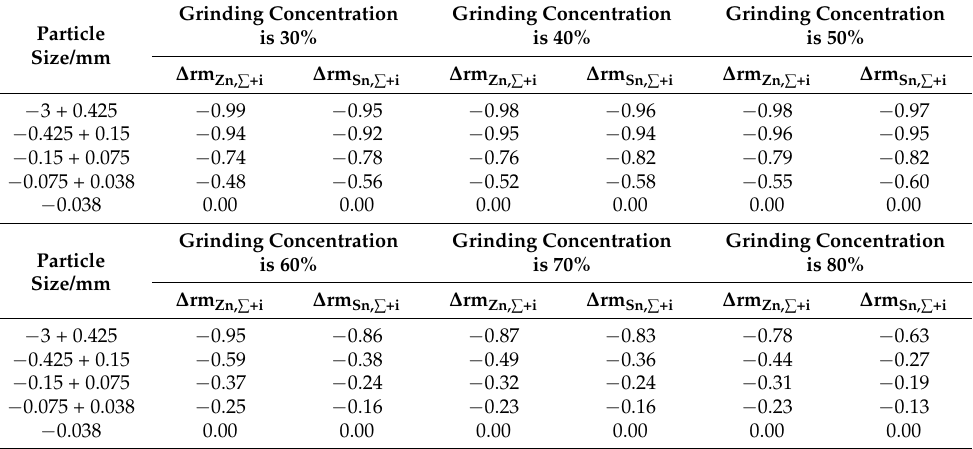
−0.15 + 0.075 −0.37